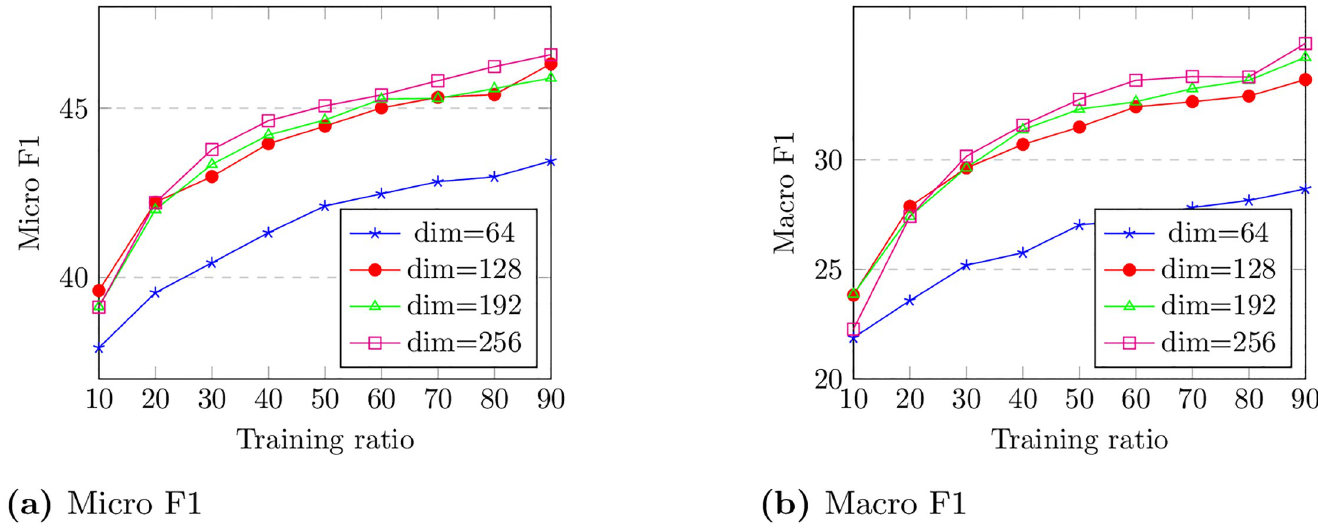
Fig 6. Performance on Blogcatalog over training ratio.